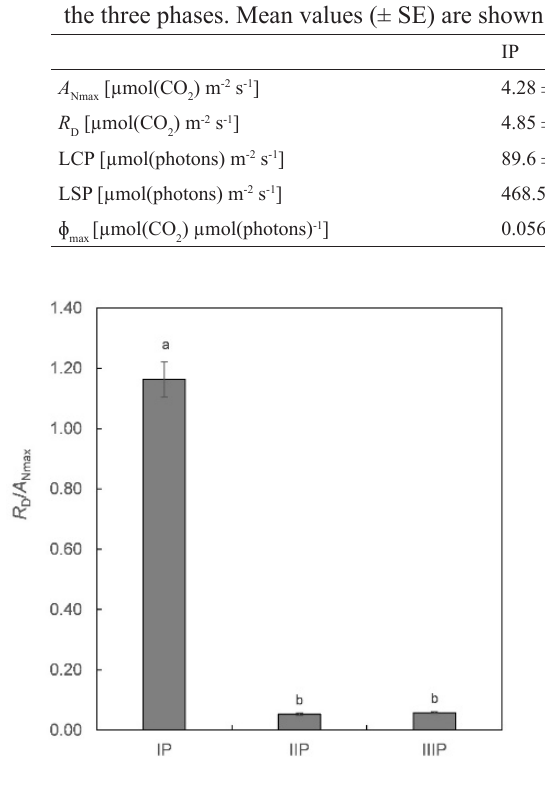
Figure 2. Values of the ratio of dark respiration rate to Figure 3. Values of chlorophyll content in three phases maximum net assimilation rate ( R / A ) in the three considered during leaf development in Corylus . D Nmax phases considered during leaf development in Corylus . IP IP = first phase at developing leaf; IIP = second phase at = first phase at developing leaf; IIP = second phase fully developed leaf; IIIP = third phase at leaf senescence. at fully developed leaf; IIIP = third phase at leaf Different letters indicate significant differences among senescence. Different letters indicate significant the three phases (ANOVA, p<0.05). Mean values (± SE) differences among the three phases (ANOVA, p<0.05). are shown (n = Mean values (± SE) are shown (n = 10).